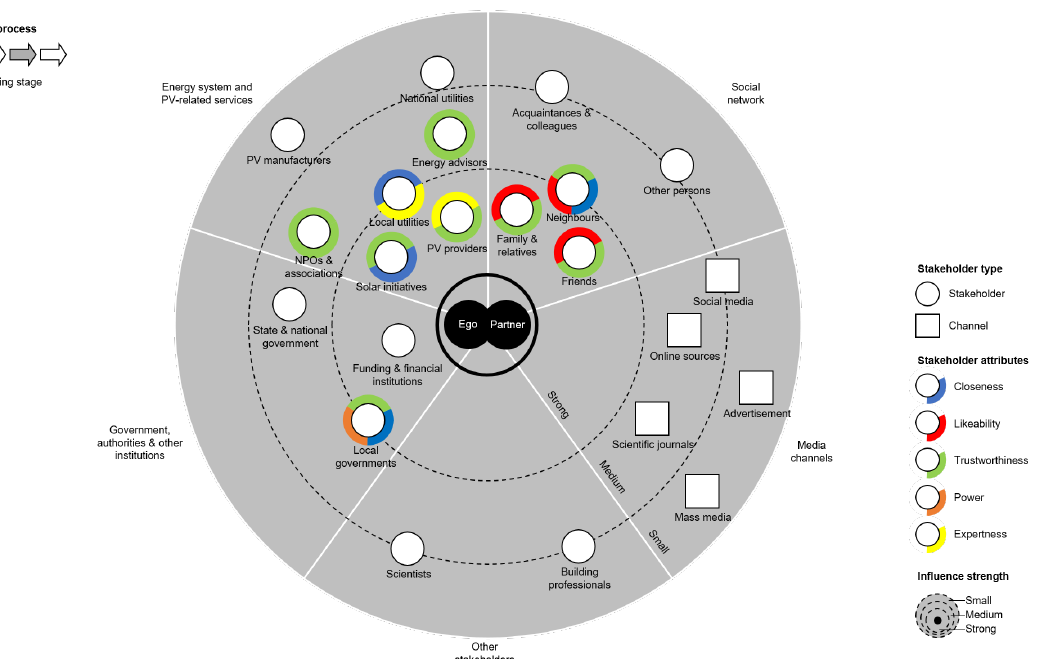
Figure 5. Visual representation of the egocentric network of the stakeholder dynamics at the planning stage. The focus is on residential PV adoption from the perspective of the household decision-maker (own